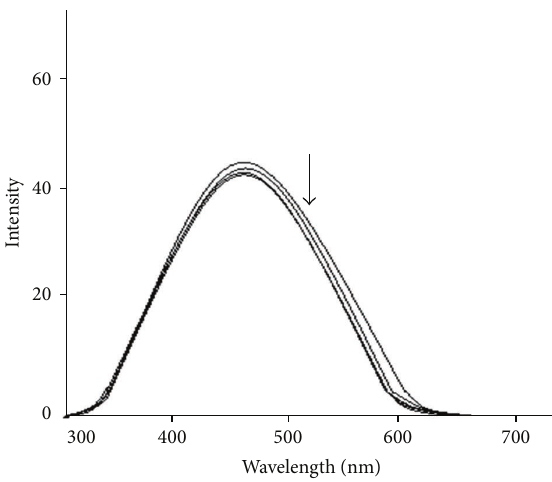
Figure 7: Fluorescence spectra of DNA-EB (10mM) in the presence of 0, 15, 25, and 35mM of complex 4. Arrow shows the changes in the emission intensity as a function of complex